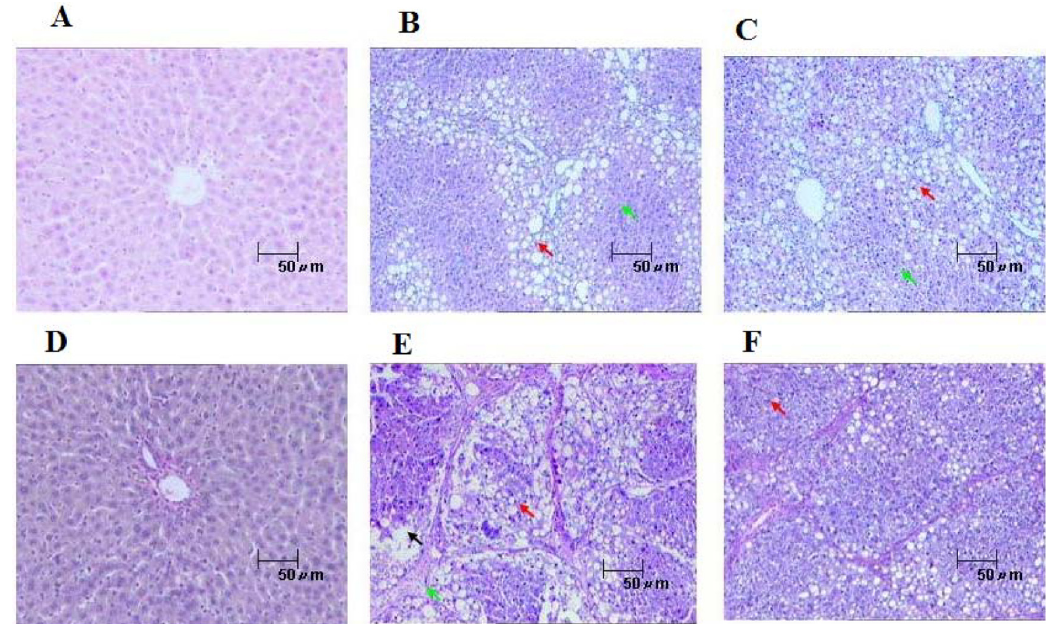
Figure 6. Hematoxylin and eosin (H&E) staining and van Gieson collagenous (VG) fiber staining. A , B and C were stained with H&E, in the normal control group, the untreated hepatic fibrosis group, and the treated hepatic fibrosis group, respectively; D , E and F were stained with VG in the three groups, respectively; A , D , a normal hepatic lobule; B , fatty degeneration of hepatocytes (red arrow) and abnormal hepatic lobules (green arrow), which were more visible than those in Panel C ; E , pseudo-lobules (red arrow), infiltration of in- flammatory cells (green arrow) and necrotic hepatocytes (black arrow); F , pseudo-lobules (red arrow), but less than those in Panel E